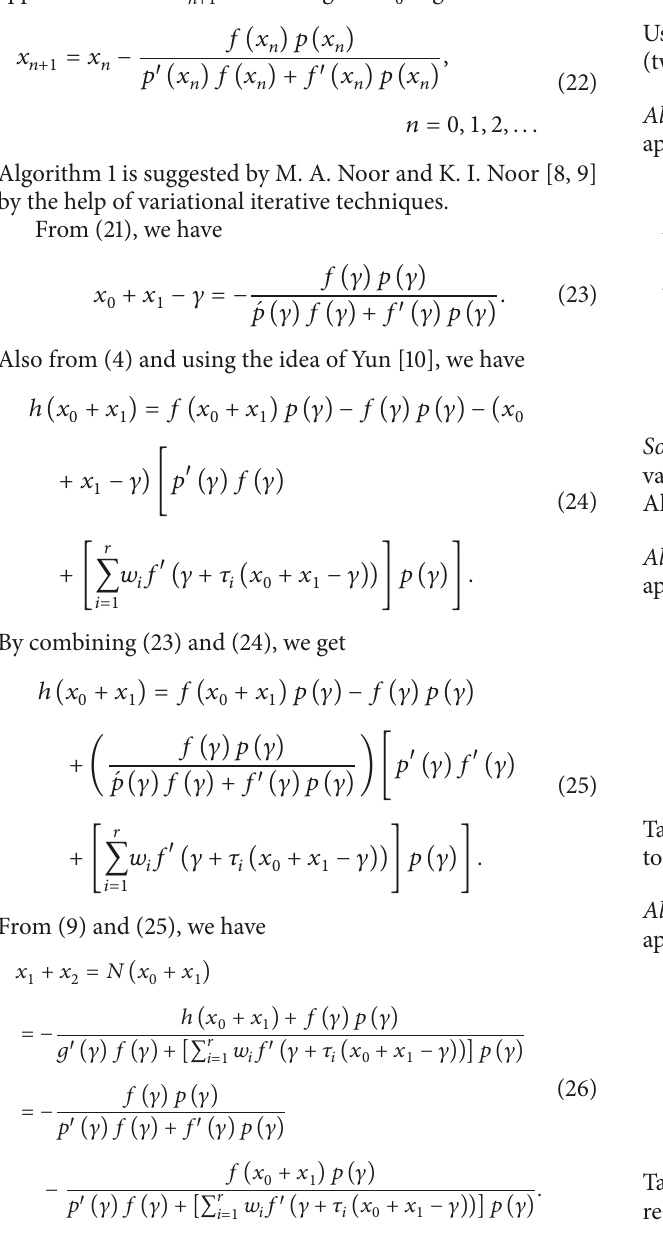
Algorithm 1. The iterative scheme which will compute the approximate root 𝑥 𝑛+1 for initial guess 𝑥 0 is given as